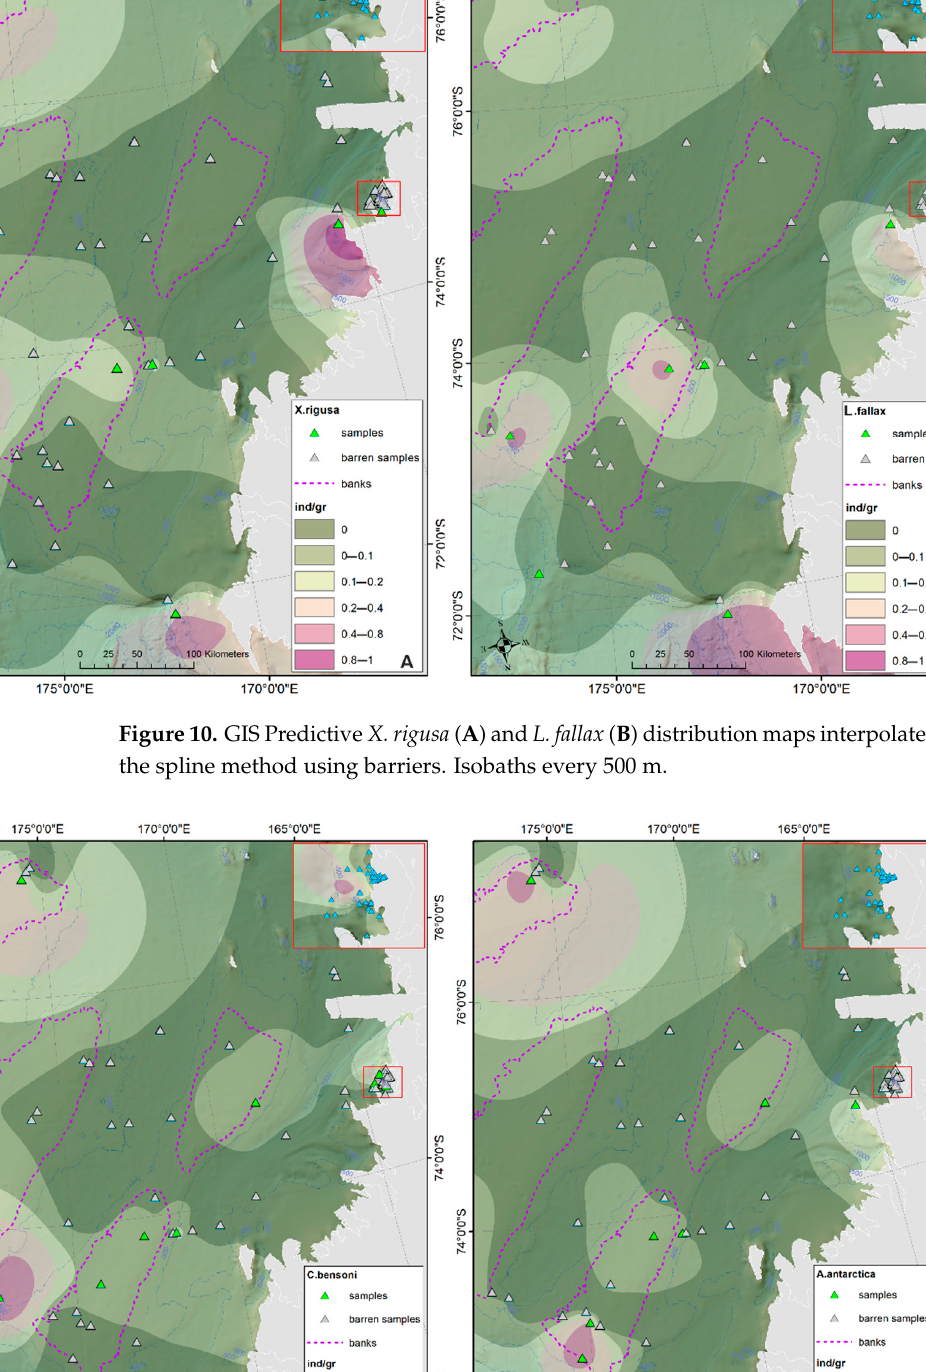
Figure 12. GIS predictive P. longiducta distribution map interpolated in GIS, applying the spline method using barriers. Isobaths every 500 m.